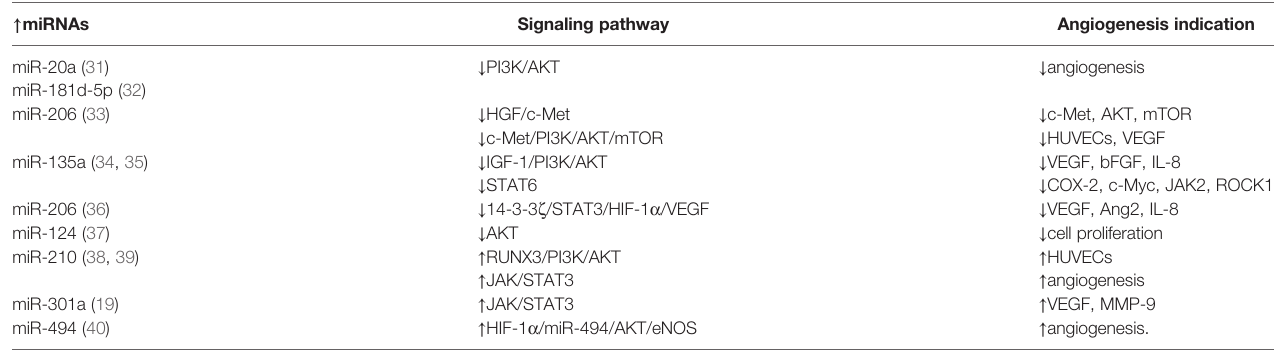
TABLE 1 | Research progress of miRNAs in angiogenesis in lung